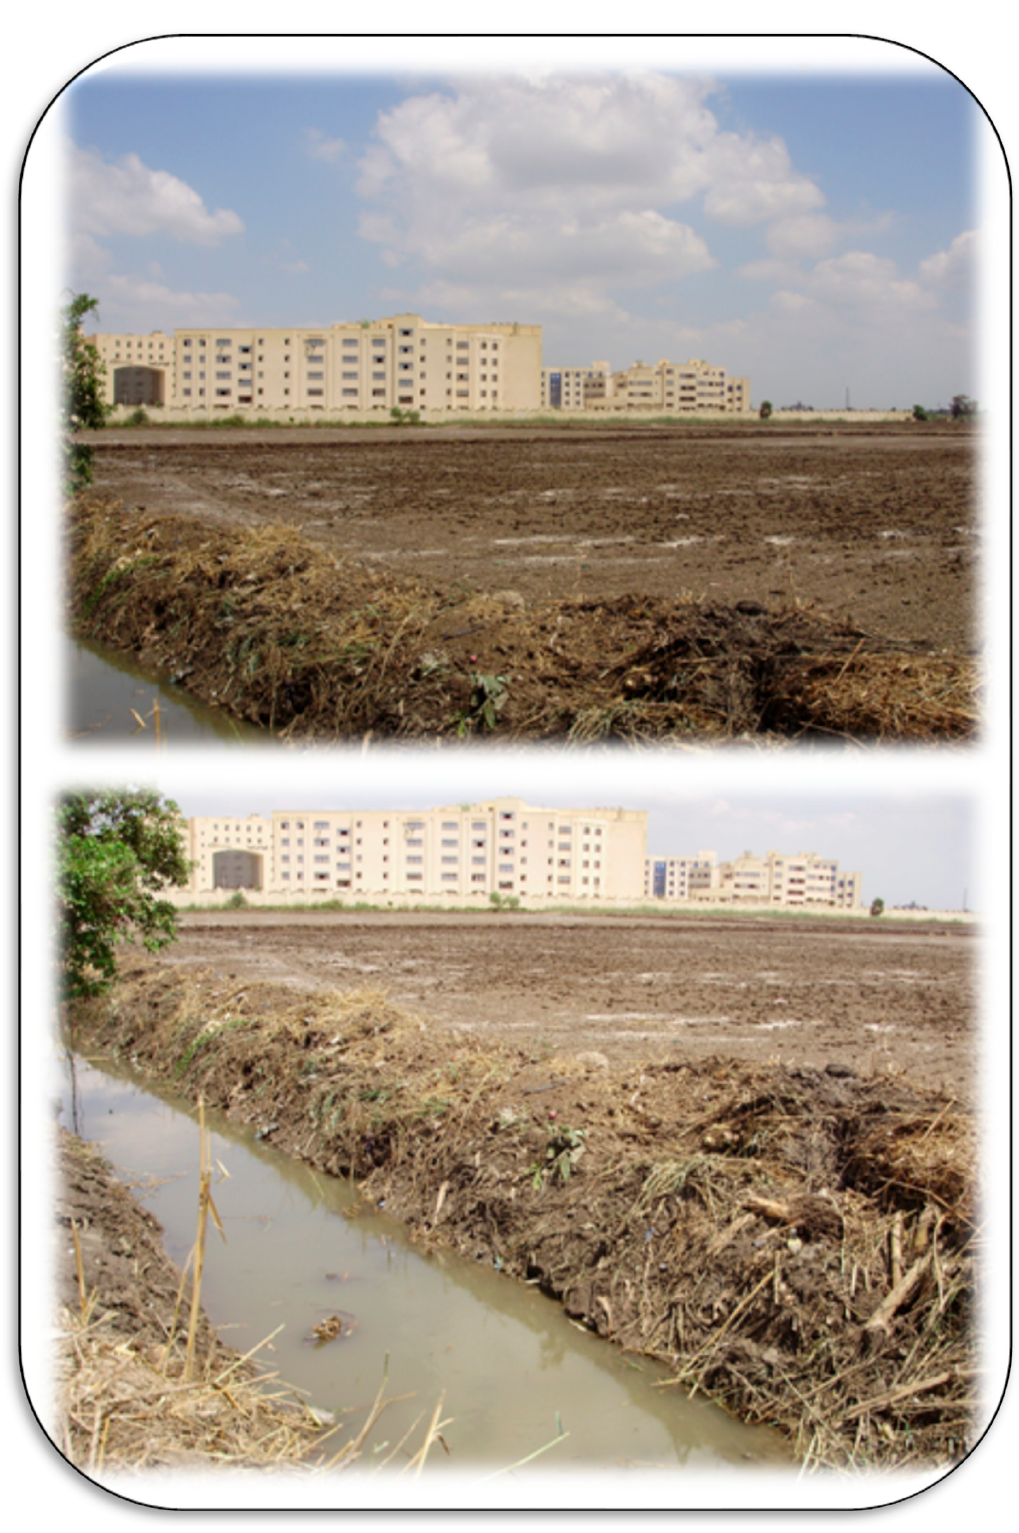
Figure 9. Saline–sodic soils in Kafrelsheikh, Egypt, could be managed using the application of gypsum (seen as the white spots on the soils in the photos). Cleaning the agricultural canals and/or drains is common at the experimental farm of Kafrelsheikh University to avoid harmful impact of Na in such soils, which is necessary to provide good drainage and reduce anthropogenically-induced salinization of the soils. Photos by El-Ramady.